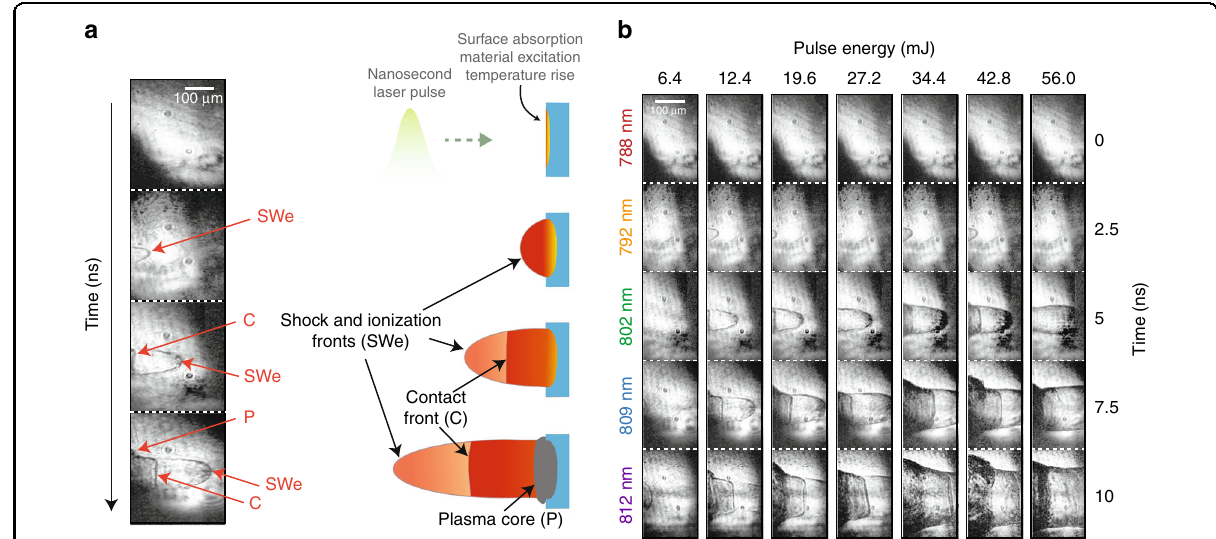
Fig. 5 Capture of laser-induced ablation dynamics in the nanosecond regime. a Birth and evolution of laser-induced gas dynamics captured using our system and illustration of the physical phenomena involved. The shock and ionization front (external shock wave, SWe), as well as the contact front evolution, are clearly observed. b Monitoring of gas dynamics during laser ablation on glass while varying the pump pulse